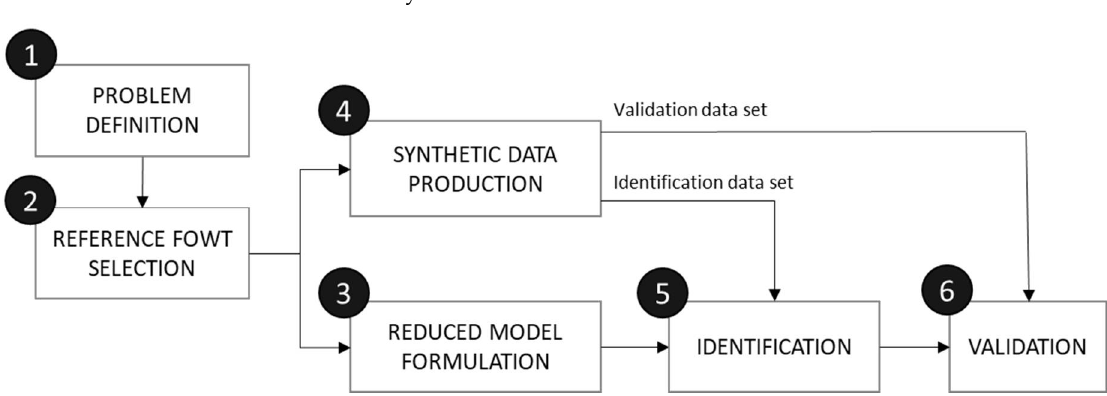
Figure 1. Key points of the identification methodology.